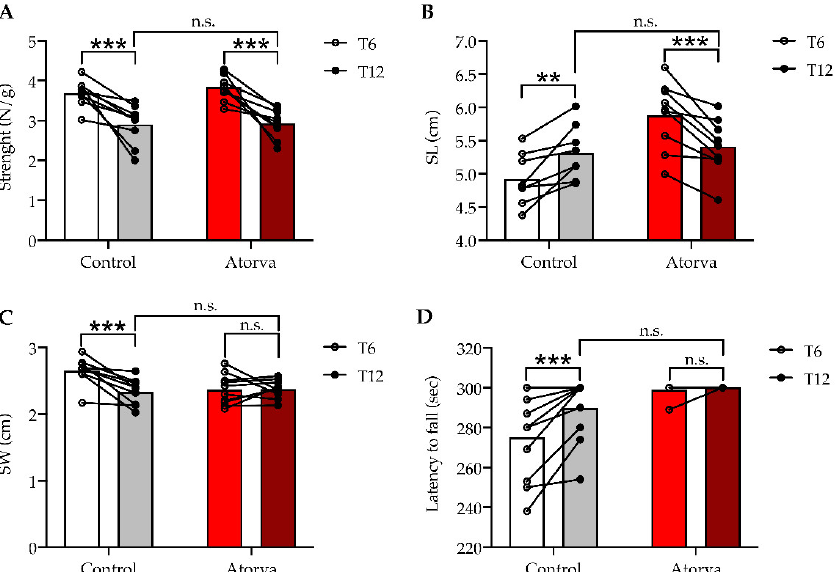
Figure 5. Muscle strength and locomotion. Grip test was used for muscle strength and data were